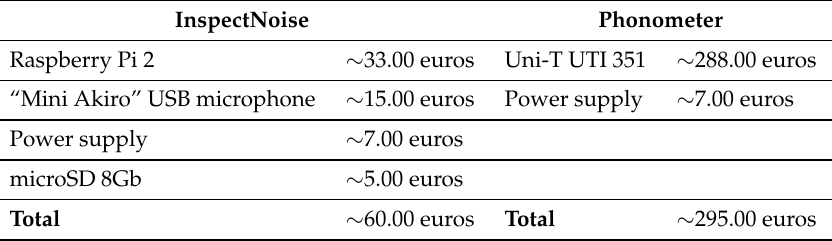
Table 2. Costs comparison between our platform and a calibrated phonometer (devices used to retrieve data and create the